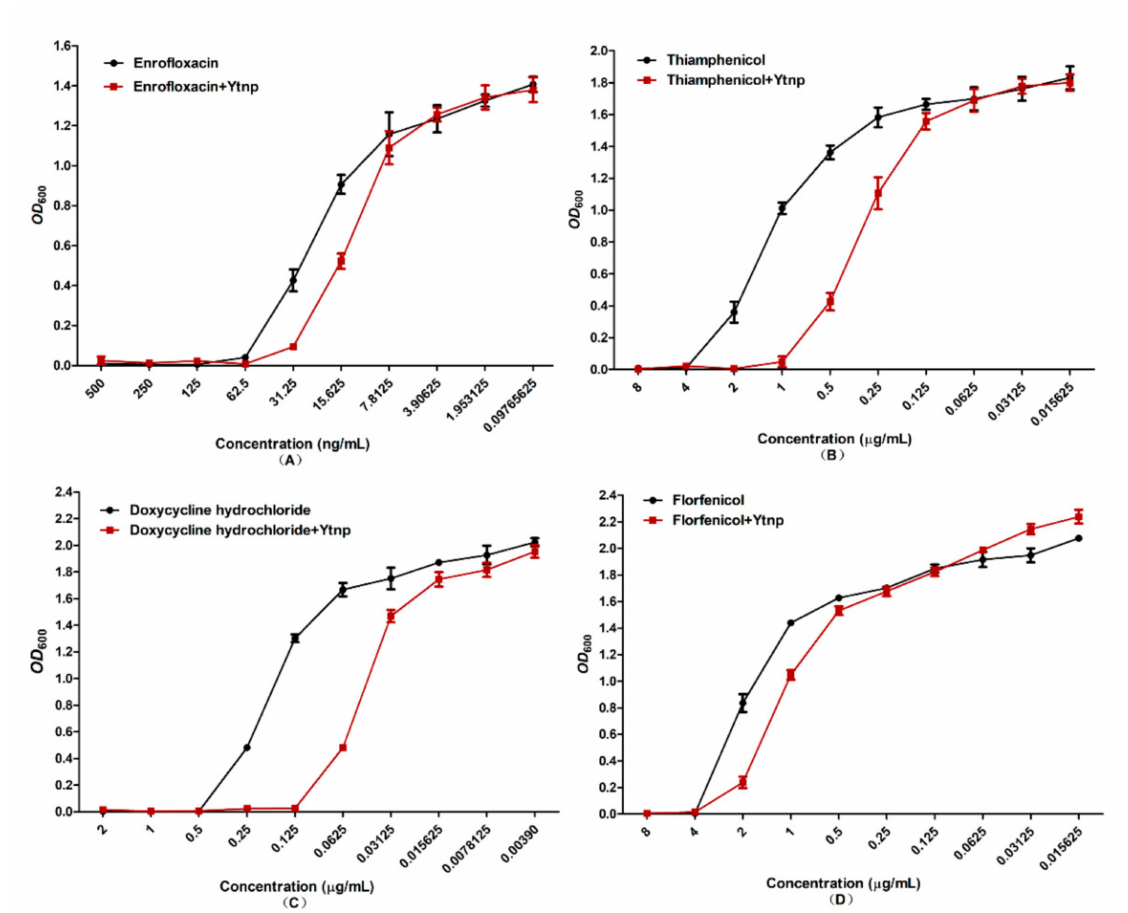
Figure 5. Synergistic effect of YtnP and antibiotics on MIC of A. hydrophila . ( A ) Enrofloxacin, ( B ) thiamphenicol, ( C ) doxycycline hydrochloride, ( D )